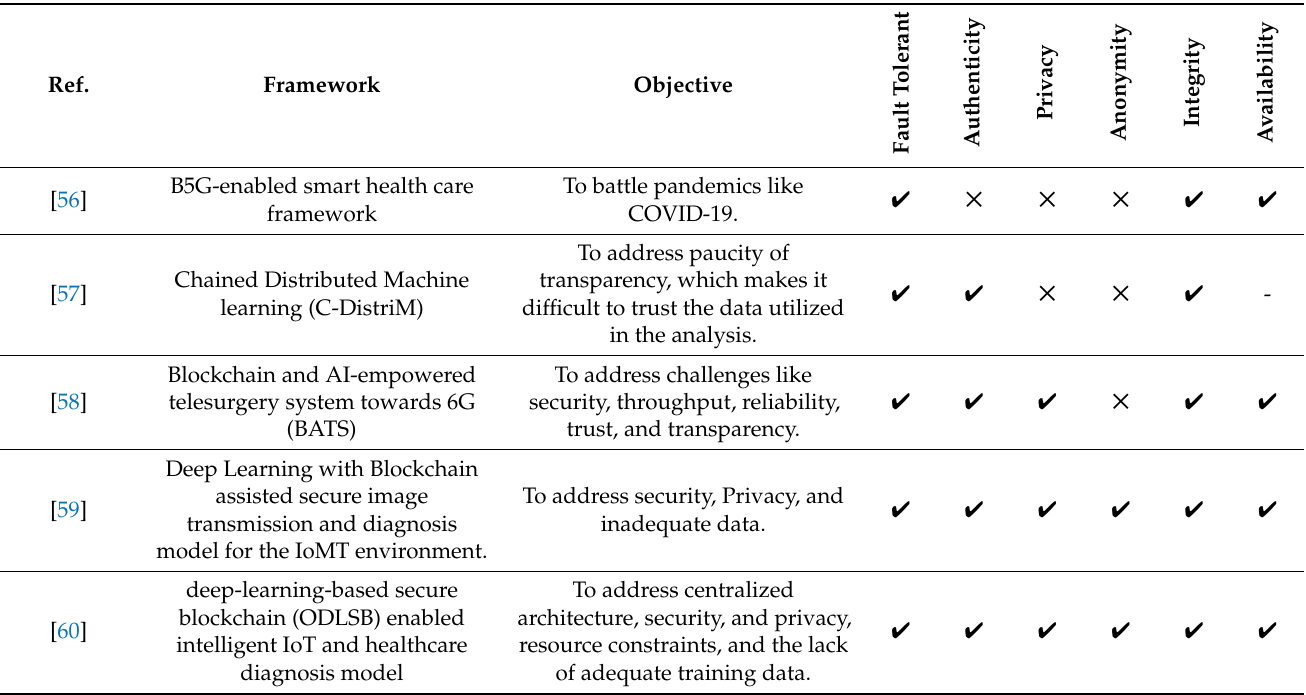
Table 17. Blockchain for AI based